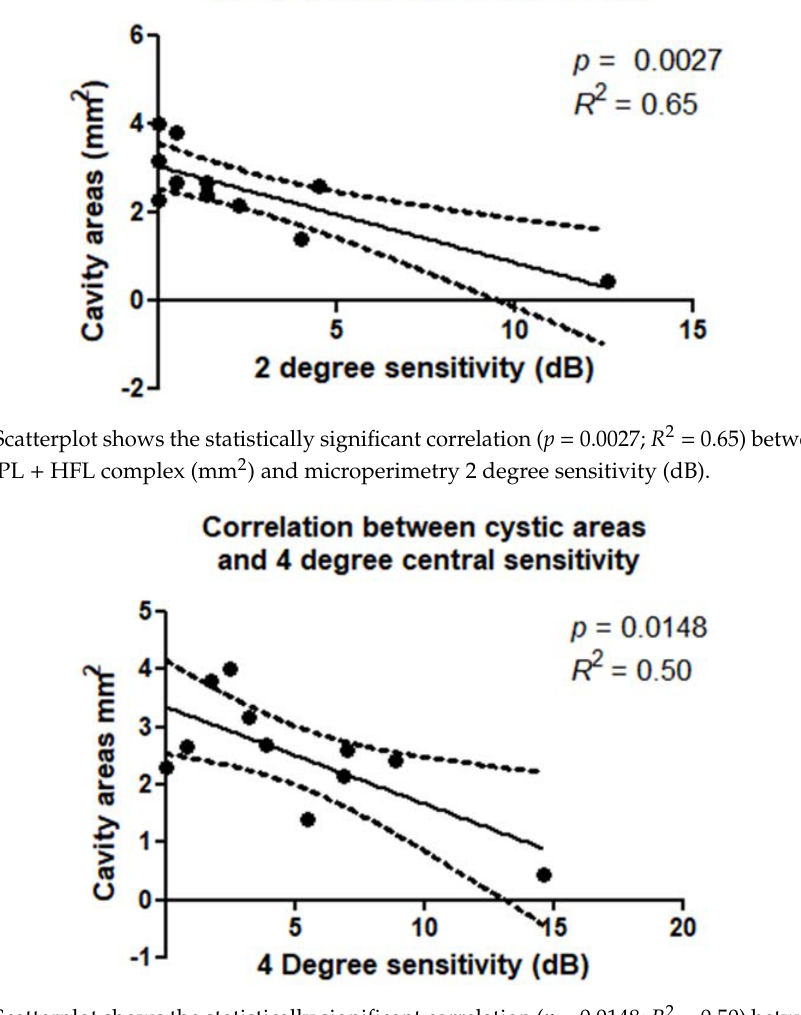
Figure 8. ( A ) Area of peak of flow in the choroidal slab (also named “choriocapillary transparency”) due to visibility of choroidal vessels caused by lack of neuroepithelium. ( B ) Scatterplot shows the statistically significant correlation ( p = 0.04, R 2 = 0.36) between the area of peak of flow in the choroidal slab (mm 2 ) and microperimetry 2 degree sensitivity (DB). 4. Discussion To our knowledge, this is the first report of a combined evaluation of structural findings (OCT, en face OCT) and functional parameters obtained by the integration of OCTA and microperimetry in patients with FTMH. To date, most preoperative prognostic features identified for macular hole surgery have been proposed based on structural cross ‐ sectional B ‐ scan OCT findings, such as the minimum linear diameter, basal hole diameter, and the properties of the outer retinal layers [6]. Several previous studies [2] on FTMH have reported a significant decrease in BCVA due to tissue loss or displacement caused by vitreomacular traction, as measured as the hole diameter. Although both the minimum diameter and basal hole diameter appear to be widely accepted as helpful for predicting visual outcomes following MH surgery, the results for these predictors vary across studies.